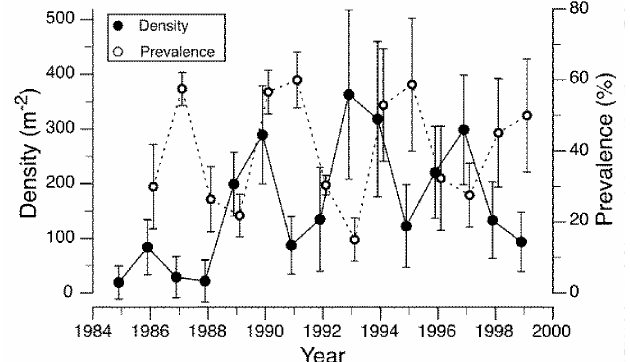
Figure 1. Larval densities (filled circles) of the univoltine caddisfly Brachycentrus americanus (mean ± 95% confidence interval (C.I.)) in 15 consecutive generations and the mean prevalence (open circles) of a microsporidium parasite, Microsporidum sp., in the larvae and pupae of B. americanus within each generation. Prevalence was calculated as the mean over all sampling dates in a generation, weighted by population density of the host on each date. Redrawn from